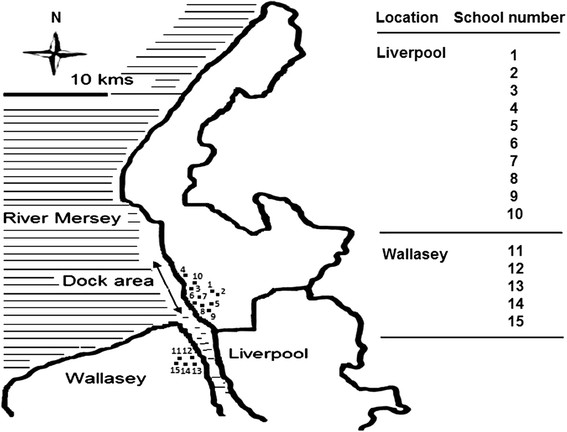
Geographical location of primary schools in Liverpool and Wallasey surveys.